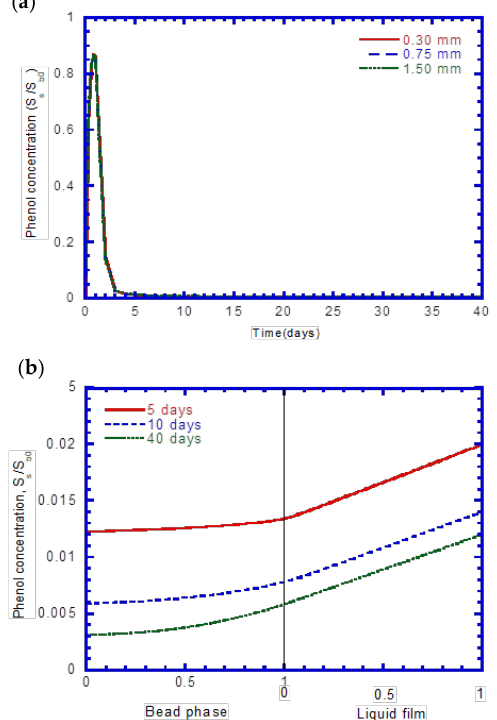
Figure 13. Model predicted phenol concentration profiles ( a ) at different radial positions and ( b ) at different operating times .